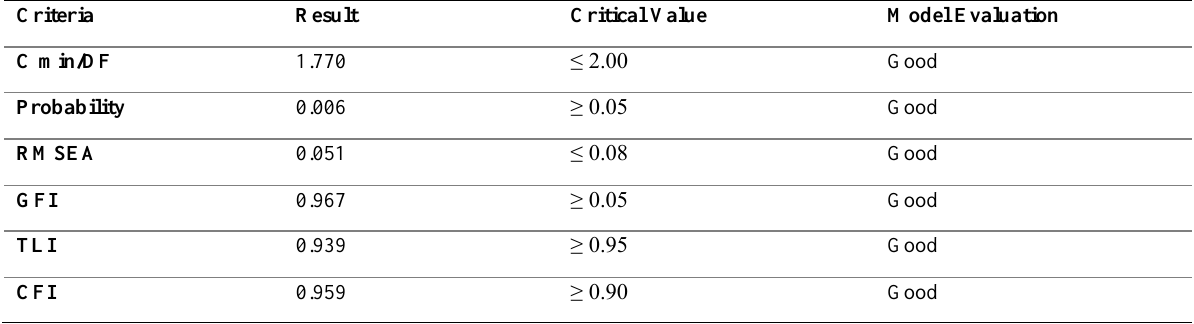
Table 3. The goodness of Fit Indices